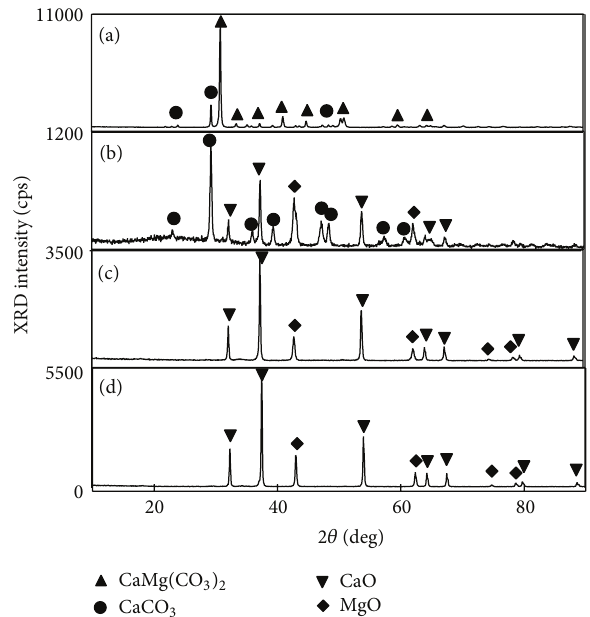
Figure 1: XRD patterns of the dolomite raw material and its pyrolysis products fabricated under different conditions. (a) Raw material, (b) pyrolysis products calcinated in an Ar atmosphere at 1173 K for 3.6 ks, (c) pyrolysis products calcinated in an Ar atmosphereat1273 Kfor3.6ks,and(d)pyrolysisproductscalcinated in vacuum at 1073 K for 3.6 ks.